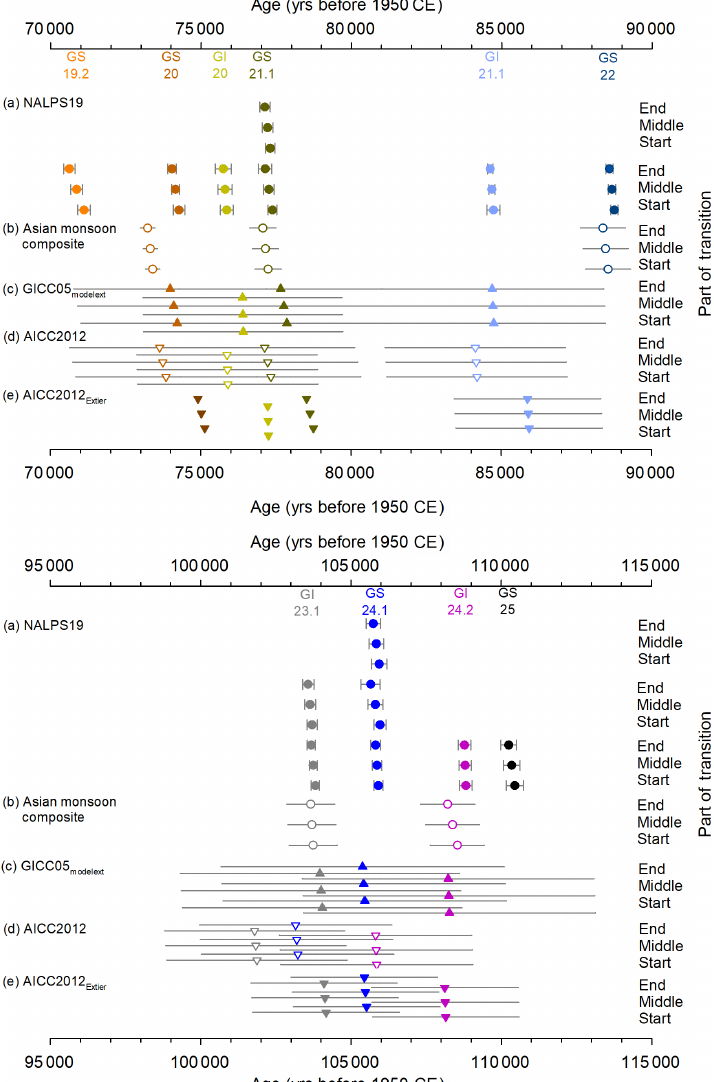
Figure 4. The timing of transitions as defined by the ramp-fitting model of Erhardt et al. (2019). The symbols relate to the age of the start, middle, and end of the transitions as defined by the ramp-fitting, whereas the uncertainty bars are related to the original chronologies. (a) NALPS19 δ 18 O calc record (closed circles; this study); (b) Asian monsoon composite speleothem δ 18 O calc record (open circles; Kelly et al., 2006; Kelly, 2010; Cheng et al., 2016); (c) NGRIP δ 18 O ice record on GICC05 modelext chronology (closed upward triangles; Wolff et al., 2010); (d) NGRIP δ 18 O ice record on AICC2012 chronology (open downward triangles; Veres et al., 2013); NGRIP δ 18 O ice record on the Extier et al. (2018) revised AICC2012 chronology (closed downward triangles). Each ramp fit relative to its reference curve is given in Fig. S7. The GICC05 modelext chronology does not contain uncertainties in this time period (Wolff et al., 2010), and thus these errors are based on the maximum counting error of Svensson et al. (2008). Extier et al. (2018) quote an uncertainty of 2440 years (2 σ ) in MIS 5. Uncertainties are not given outside of